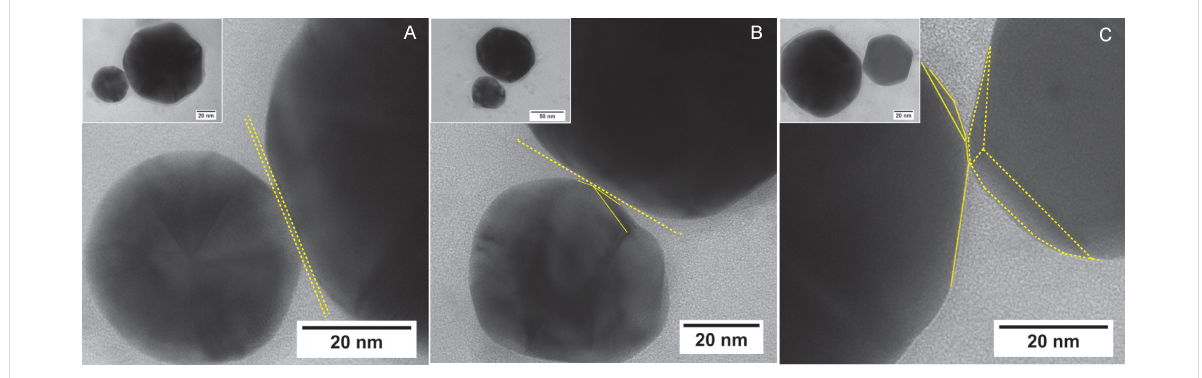
Figure 6: Morphologies of dumbbell dimers with sub-nanometer gap sizes. (A) Dimer with a planar gap. (B) Dimer with a gap formed by a large facet of the 80 nm AuNP and edge of the 40 nm AuNP. (C) Dimer with a pointed gap morphology formed by the interaction of the facet edges/corners of both contributing